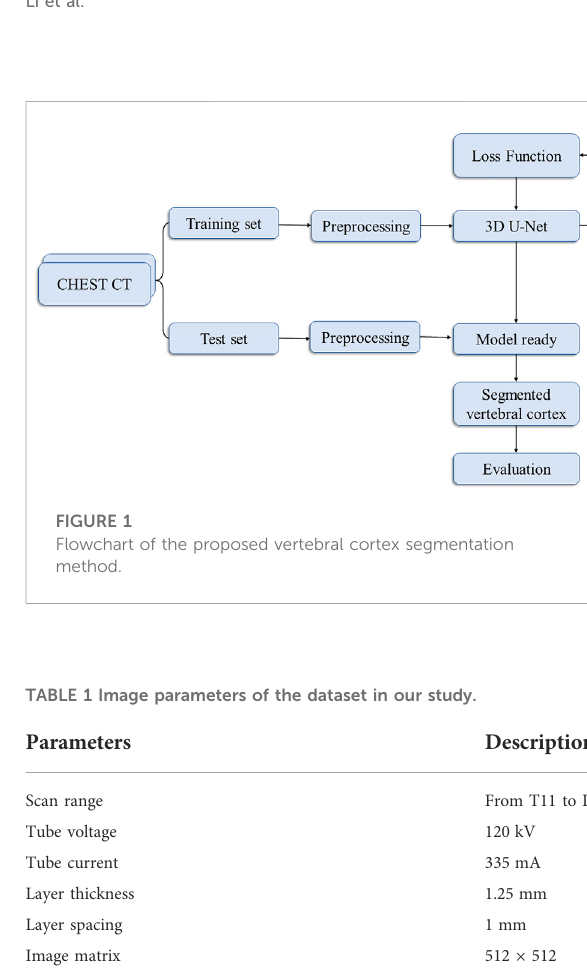
Figure 1. All the participants were performed on a 256-slice CT scanner (GE Healthcare), with image acquisition parameters listed in Table 1. The same protocol was used to process all of the scans.